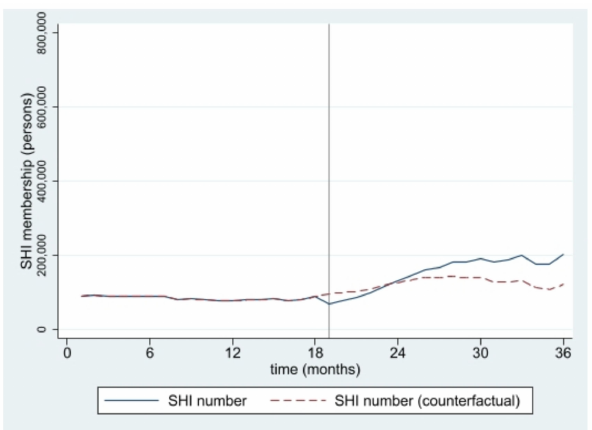
Figure 5. SHI membership, border provinces (2016–2018).